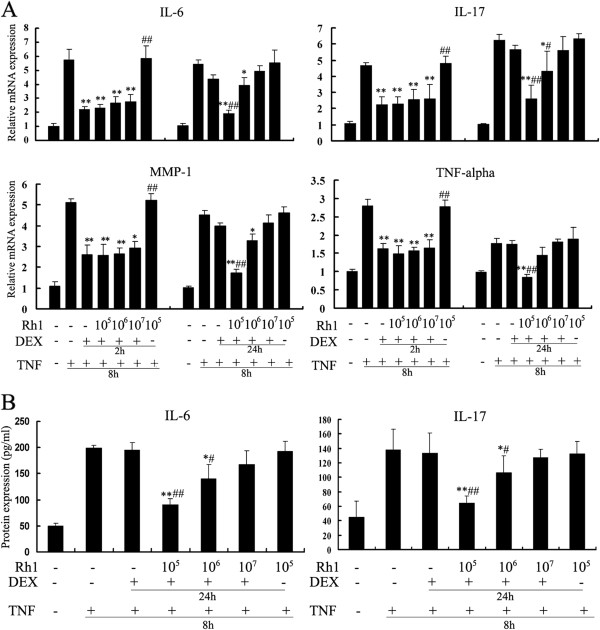
Effects of ginsenoside Rh1 combined with DEX on TNF-induced cytokine production. RAW264.7 cells were pretreated with solvent, DEX (1 μM) or DEX combined with Rh1 (10 μM, 1 μM, 0.1 μM ) or Rh1 alone for 2 h (short-term treatment protocol) or 24 h (prolonged treatment protocol), as indicated in the figures. Afterwards, TNF (20 ng /ml) was added for 8 h. (A) Expression of the pro-inflammatory mediators IL-6, IL-17, MMP-1 and TNF-α was monitored by means of quantitative PCR. Gene expression of the housekeeping gene β-actin was used for normalization. (B) Protein expression of IL-6 and IL-17 were also determined by ELISA. Statistical significance was determined by one-way analysis of variance (*P <0.05, **P <0.01 versus TNF group; #P <0.05, ##P <0.01 versus the DEX group). The experiments were replicated three times, and results are representative of at least three independent induction experiments. DEX, dexamethasone; IL, interleukin; MMP-1, matrix matalloproteinase-1; TNF, tumor necrosis factor.